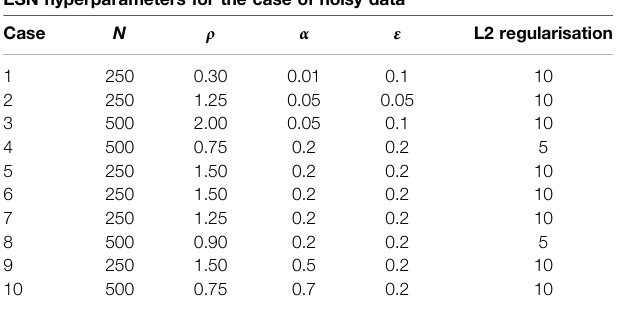
TABLE 5 | Selected ESN hyperparameters for the case of blurred data. ESN hyperparameters for the case of noisy data